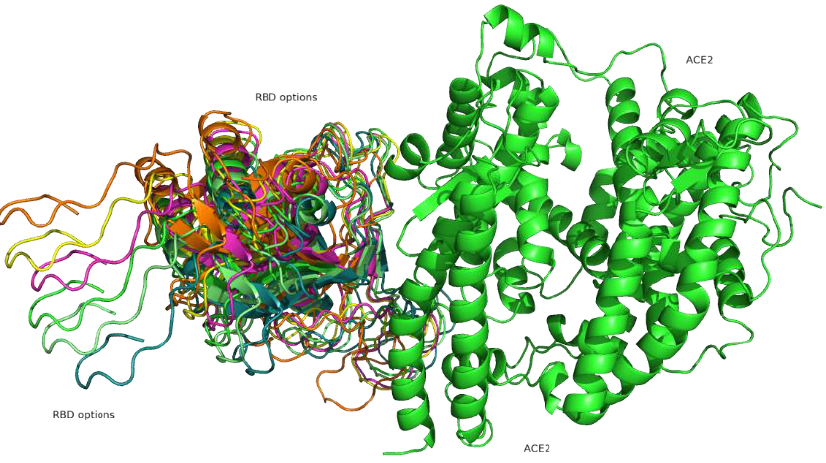
Figure 7. Computational Prediction of binding receptor domain (BRD) from the spike protein and the ACE2 receptor, showing all possible interactions. the ACE2 receptor, showing all possible